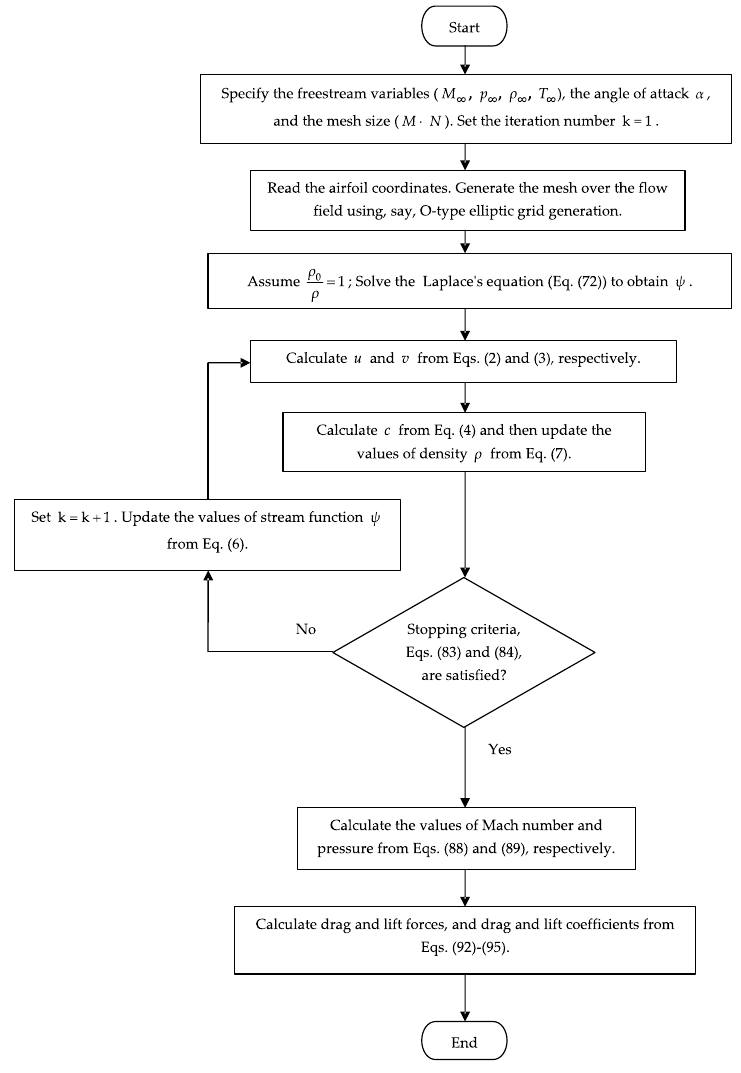
Figure 9. Flowchart of computational procedure.